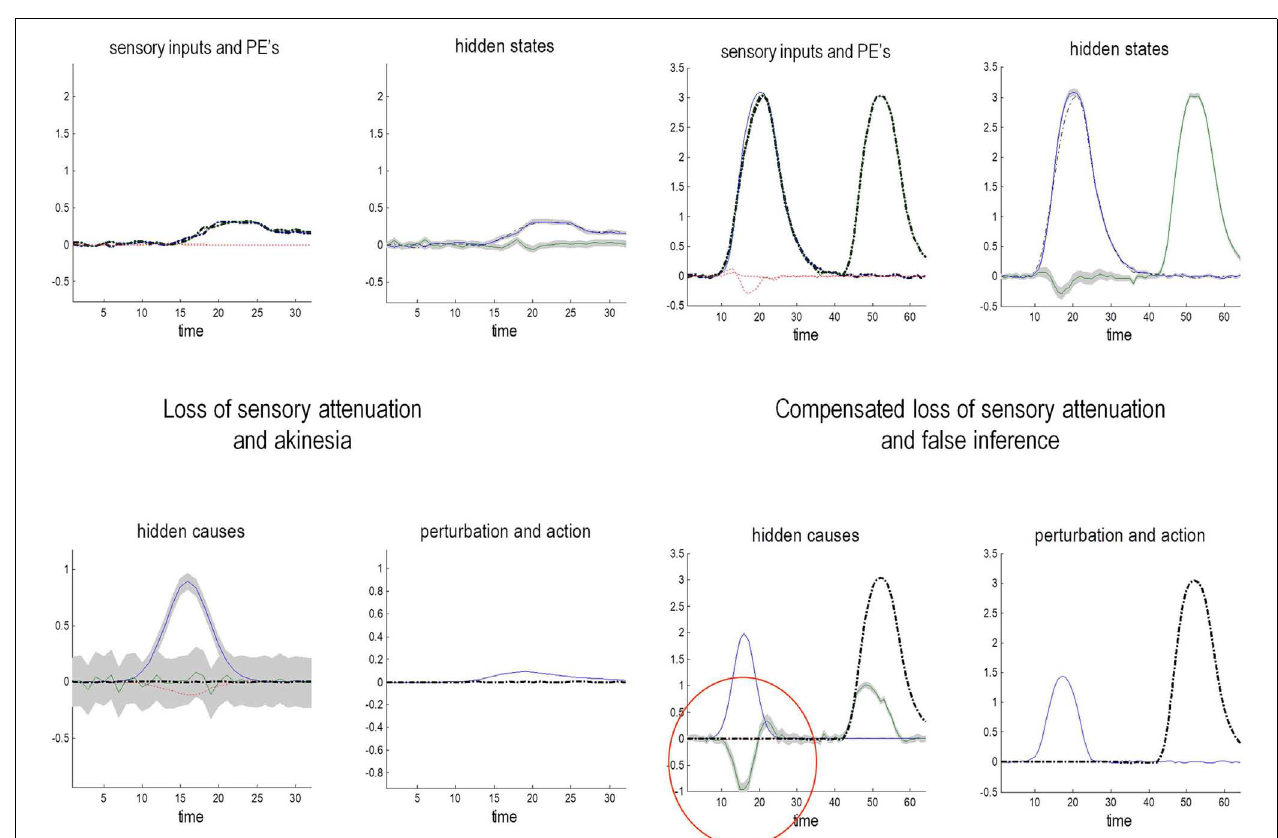
movement.The underlying failure of sensory attenuation still enables a precise and accurate perception of internally and externally generated sensations (upper left panel). However, the causes of sensory data are not accurately inferred: a false (delusional) cause (lower left panel) is perceived during internally generated movement that is antagonistic to the movement. This is because the proprioceptive prediction errors driving action are rendered overly precise, meaning higher levels of the hierarchy must be harnessed to explain them, resulting in a delusion that exogenous forces are opposing the expected outcome (encircled in